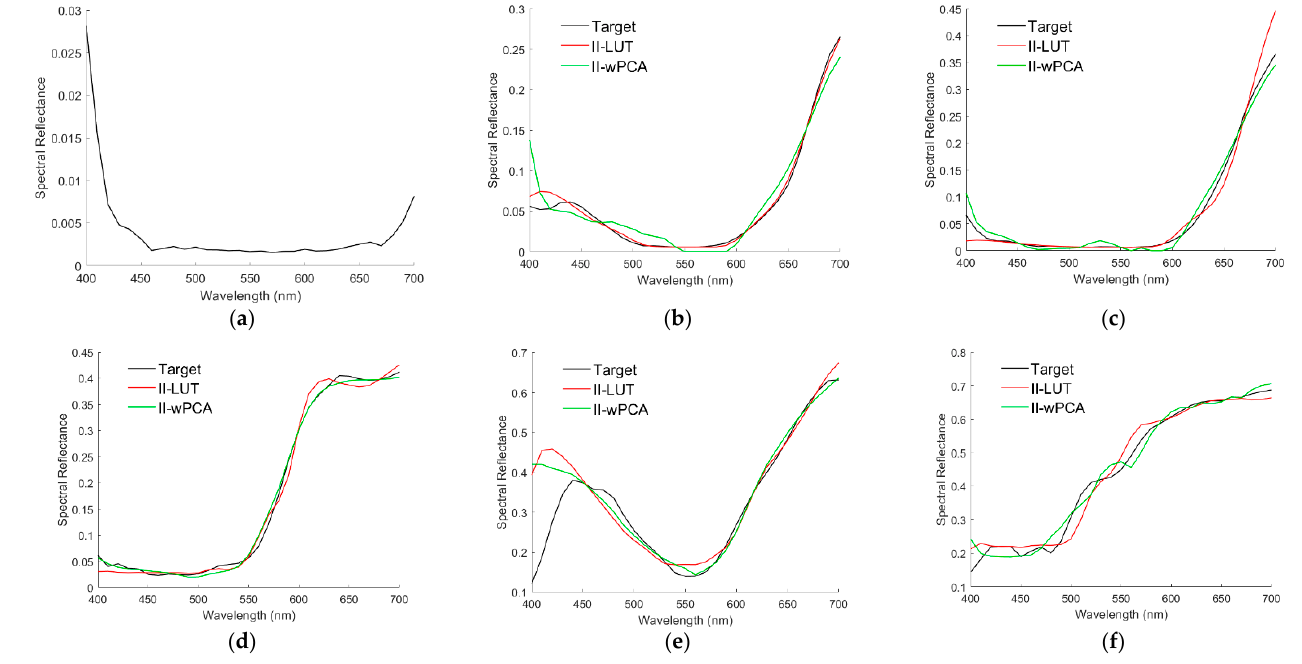
Figure 21. ( a – f ) showing the target spectral reflectance of the pixel at the center of the white circle in Figure 20a–f, respectively. ( b – f ) also show the recovered spectral reflectance using the II-LUT and II-wPCA methods.